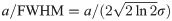
Relative error of the thickness estimation under two levels of simulated Gaussian noise.For the range of true thickness values normalized by the full width at half maximum (FWHM) of the Gaussian (a/FWHM=a/(22ln2σ)), mean value and standard deviation of the corresponding relative error were computed after 250 simulations. These statistical parameters are shown for three methods using three different colors. True reference BMD was used (800 mg/mm), σ = 1.5 mm, c = 150, and b = 0 mg/mm. (a) Noise level = 30 mg/mm; (b) Noise level = 37 mg/mm.